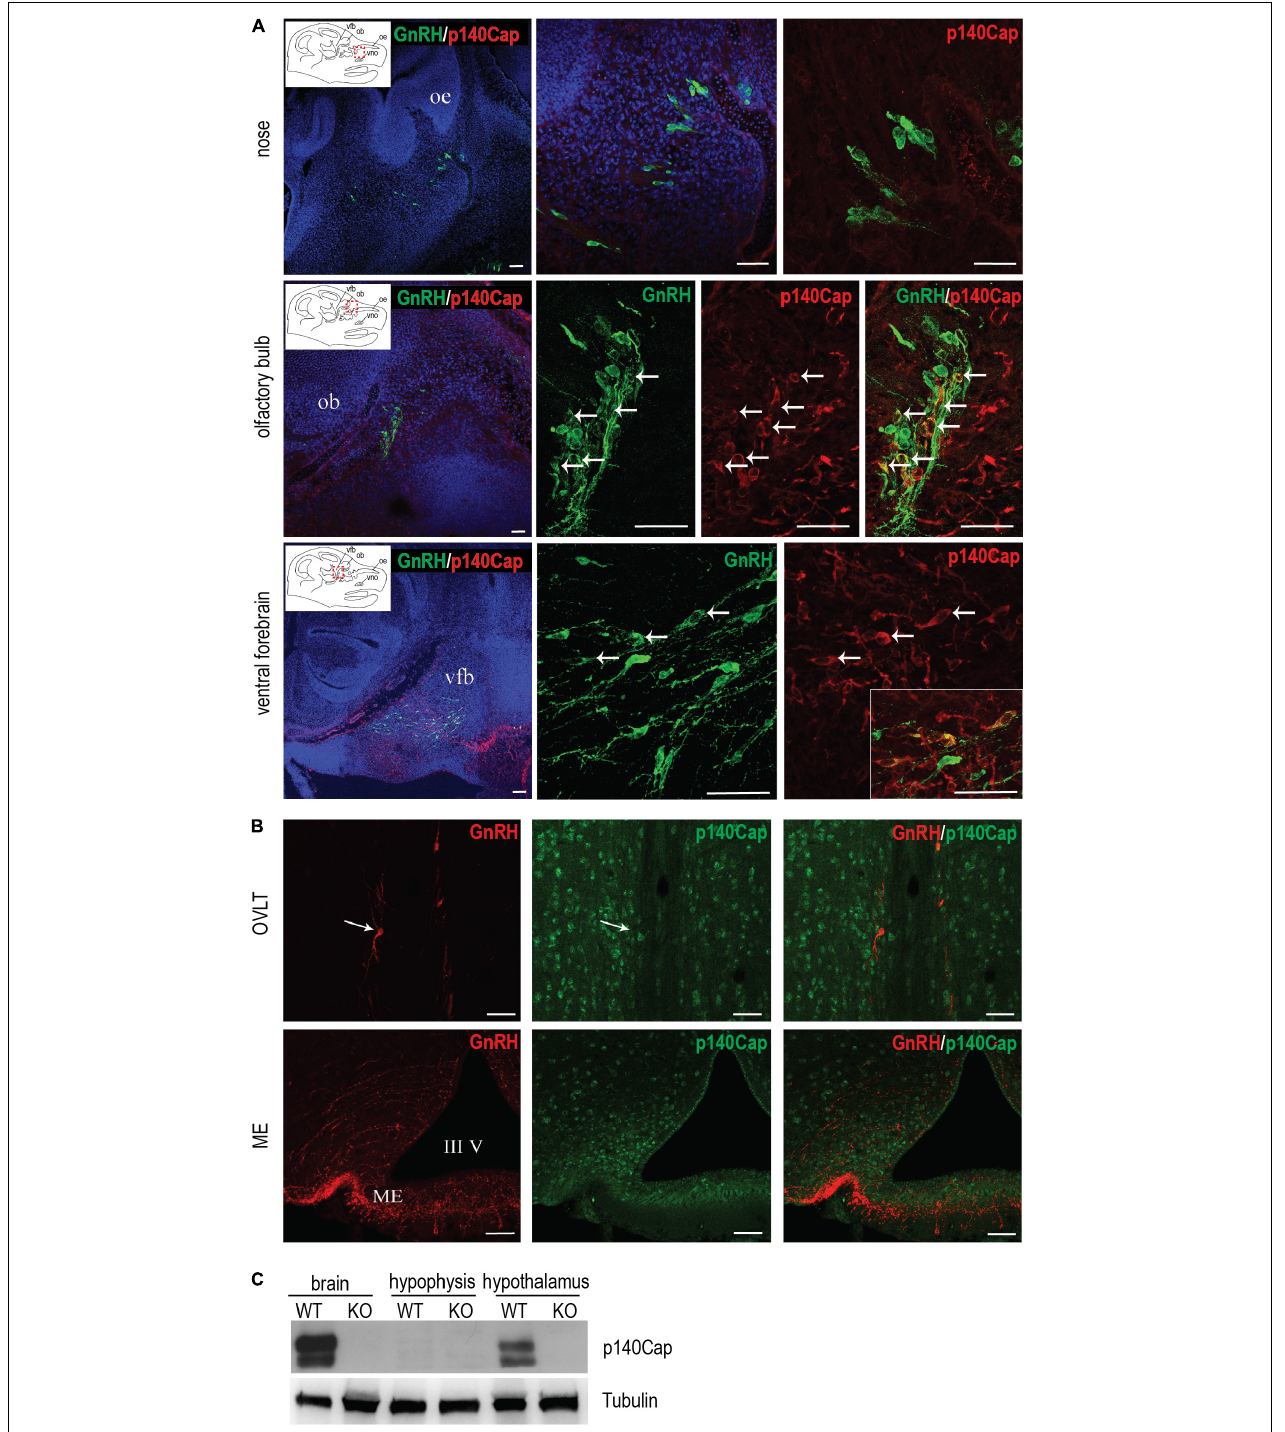
FIGURE 4 | p140Cap is expressed in a subpopulation of GnRH neurons during embryonic development. (A) Confocal optical sections of the expression of GnRH (green) and p140Cap (red) in the nose, olfactory bulb, and ventral forebrain of E14.5 WT embryos. Sections were counterstained with DAPI (blue). oe = olfactory epithelium; ob = olfactory bulb; vfb = ventral forebrain, vno = vomeronasal organ. Scale bars: 50 µ m. (B) Confocal optical sections of the expression of GnRH (red) and p140Cap (green) in the organum vasculosum of the laminae terminalis (OVLT) and median eminence (ME) of WT P60 mice. Sections were counterstained with DAPI (blue). III V = 3 rd ventricle. Scale bar: 50 µ m. (C) Protein level of p140Cap in the total brain, hypophysis, and hypothalamus of p140Cap KO and WT P60 mice, evaluated by western blot. Protein extracts were run in 6% SDS-PAGE. Membranes were decorated with anti-p140Cap antibody (top) and anti-tubulin antibody, as a loading control